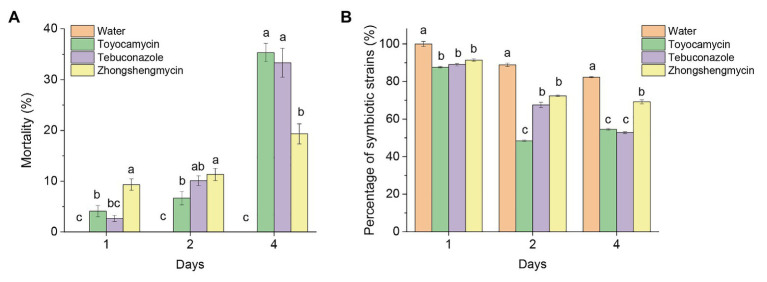
Effect of antibiotics on the mortality and number of strains in BPH. (A) Mean mortality (±SE) of adult BPH after the treatment of three antimicrobials on days 1, 2, and 4. (B) Effect of antimicrobials on the total number of yeast-like symbionts (YLSs) in the fat body, except the head, legs, and thorax, the number of YLSs in the control group at the day 1 was regarded as 100%. Values are mean ± SE, where n = 5. Different letters on the top of each bar indicate that the data are significantly different by Tukey test for multiple comparisons with a significance threshold of p < 0.05. The control group was treated with water.